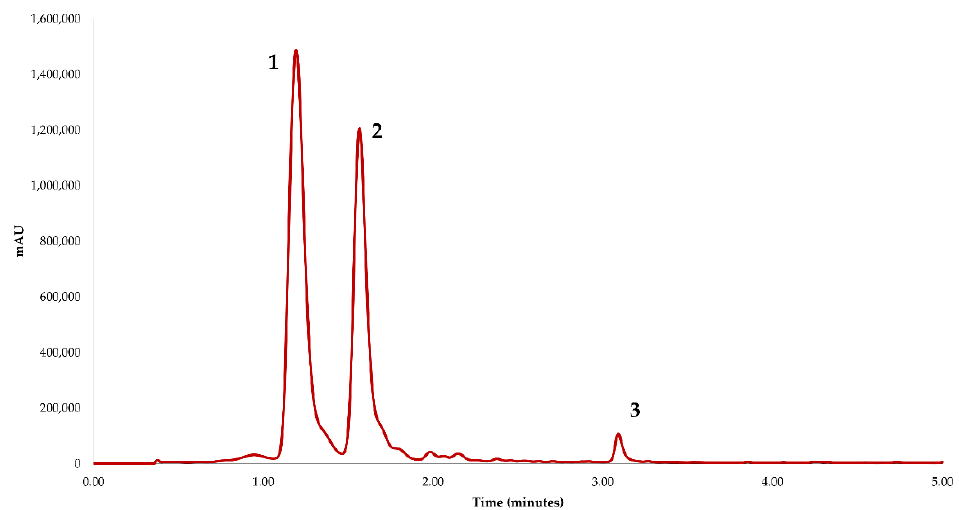
Figure 1. Chromatogram of the betalains identified in Opuntia dillenii extracts ( λ = 540 nm). 1. Betanin; 2. Isobetanin; 3. Neobetanin.